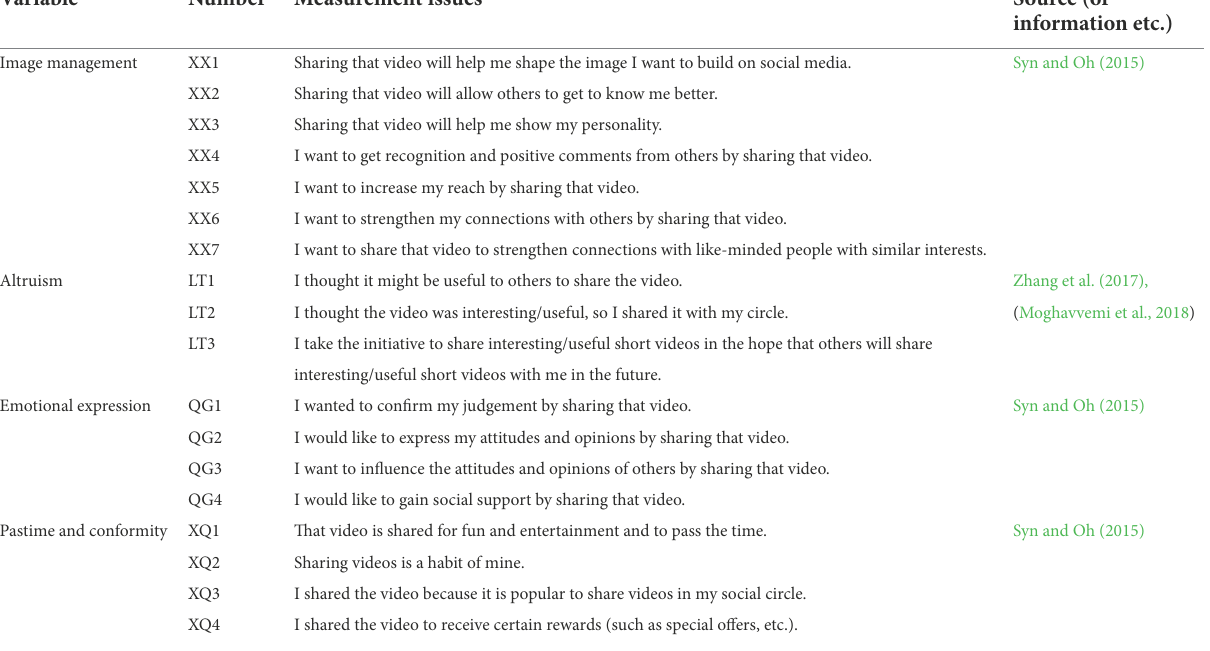
TABLE 2 User motivation to share measurement